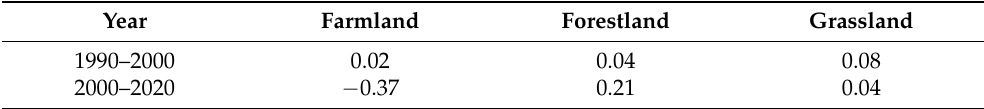
Table 7. Dynamic degree of cultivated land, forestland, and grassland in Shaanxi Province from 1990 to 2020 (in %).